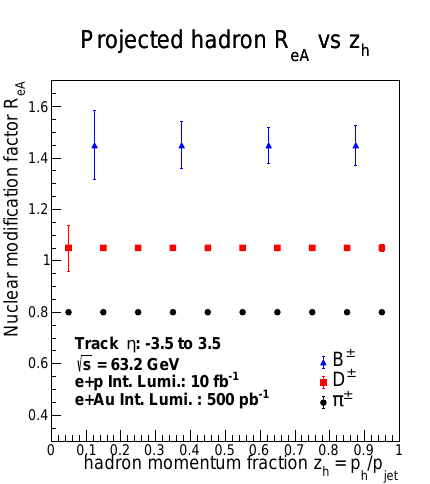
Figure 5: Projected statistical accuracies of flavor dependent nuclear modification factor R for reconstructed hadrons with different flavors (left) and pseudorapidity eAu separated reconstructed D 0 ( ¯ D 0 ) R (right) in 10 f b − 1 e + p collisions and 500 pb − 1 (cid:112) eAu s = 63.2 GeV. The reconstructed hadron yields are extracted from e + Au collisions at PYTHIA simulations with the proposed silicon vertex / tracking detector performances using the Babar